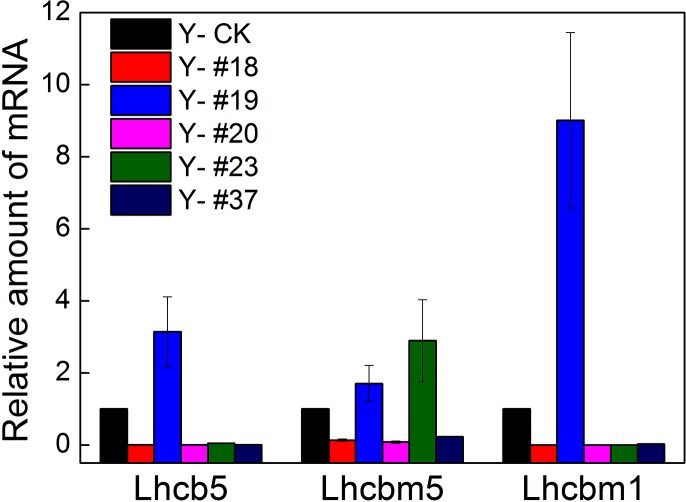
Expression of Lhcb5, Lhcbm5 and Lhcbm1 genes in the five progenies.The levels of the indicated mRNAs in the five progenies were determined by qRT-PCR after 8 d of cultivation. The 18S rRNA gene was used as a reference gene. n = 4+SD.